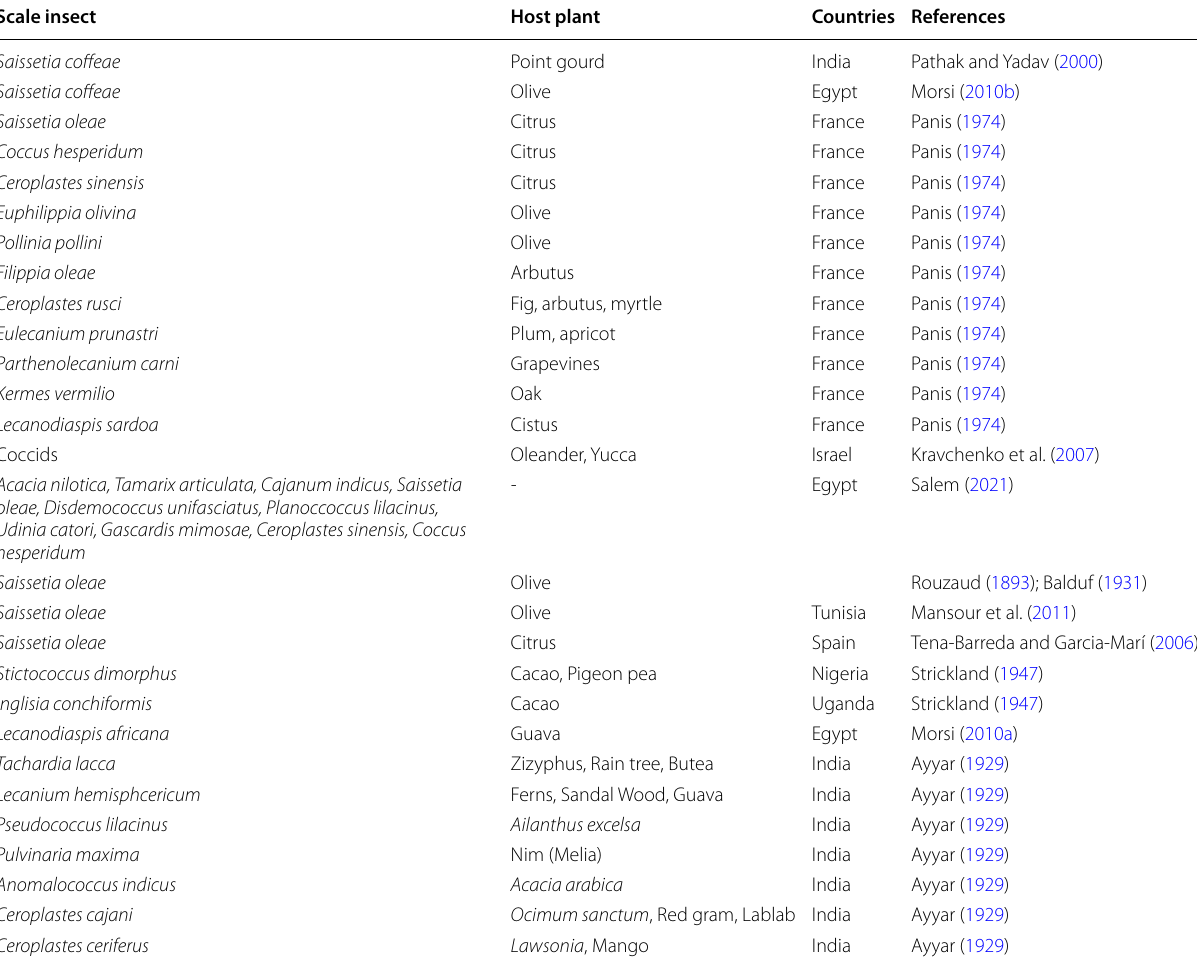
Table 1 Occurrence of Eublemma scitula on different species of scale insects Scale insect Host